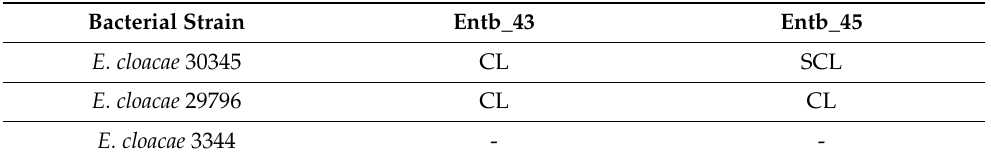
Table 2. Results of phage typing. CL—confluent lysis; SCL—semiconfluent lysis; +++—60 and more plaques; ++—20–60 plaques; OL—opaque